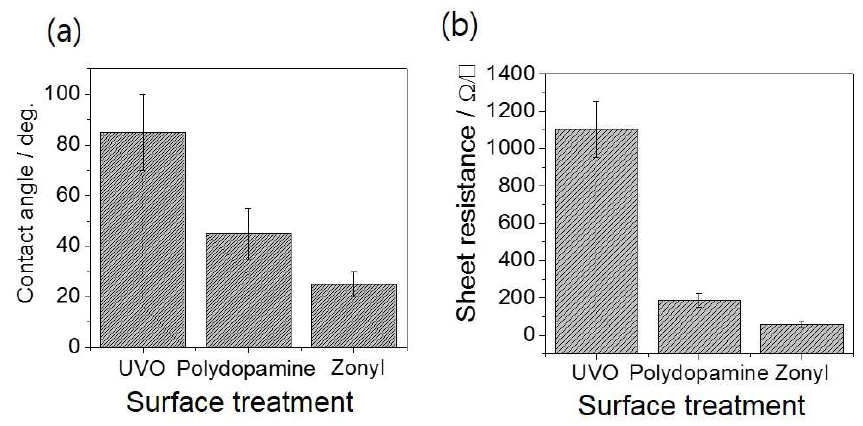
Figure 3. ( a ) Contact angle of the water droplet on the SBS nanofiber film after different surface treatments (UVO, Polydopamine, Zonyl); ( b ) Sheet resistance following three different surface treatments.